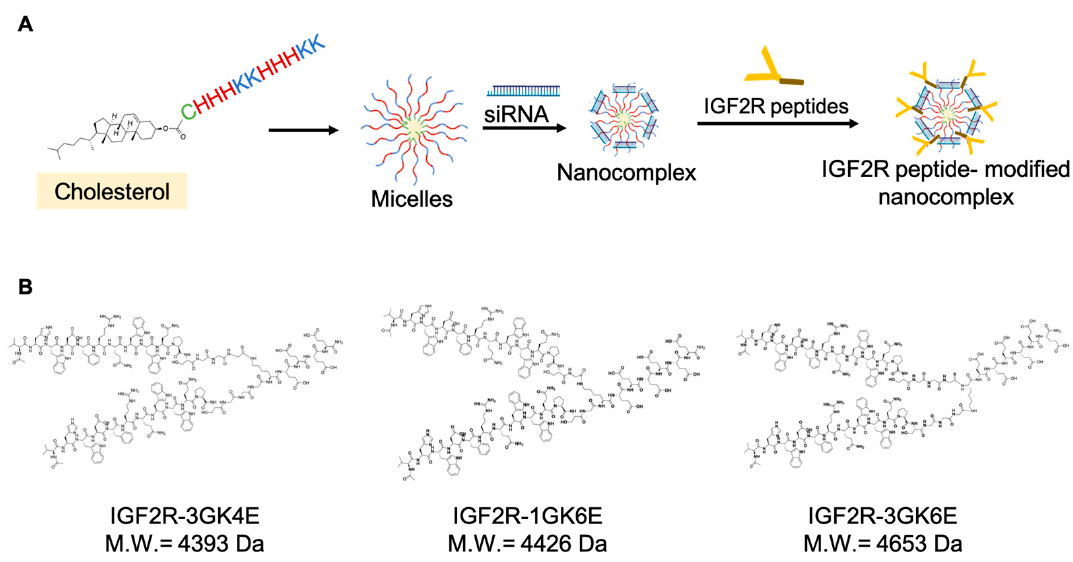
Figure 1. Schematic diagrams of the siRNA nanocomplex. ( A ) The fabrication schemes of dimeric IGF2R peptide-modified siRNA nanocomplex. ( B ) The structure of dimeric IGF2R-3GK4E peptide, IGF2R-1GK6E peptide, and IGF2R-3GK6E peptide. Cholesteryl peptide and Pcbp2 siRNA were mixed in N/P ratio 10:1 at room temperature, followed by condensation with IGF2R peptide ligands to form the final nanocomplex.